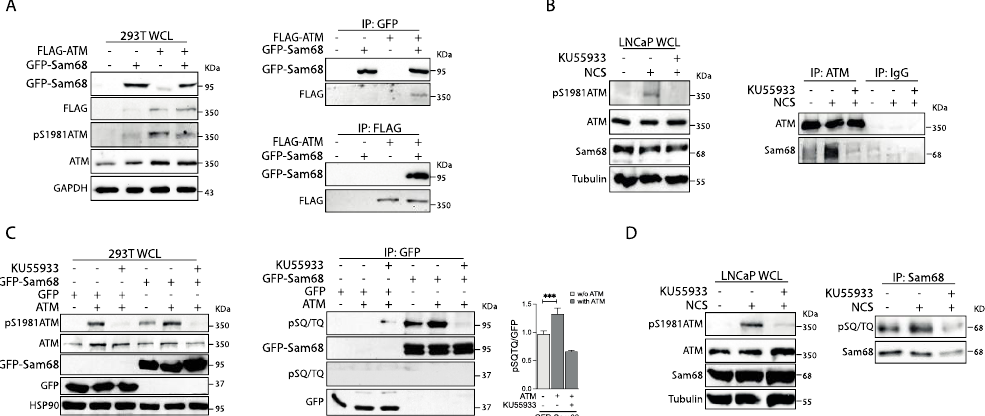
Figure 2. Sam68 interacts with ATM kinase, and it is phosphorylated on SQ/TQ motif upon DDR induction. ( A ) HEK293T cells were transiently transfected with a combination of different constructs that allow the overexpression of the fusion proteins GFP-Sam68 (pCDNA GFP-Sam68) and ATM-Flag (pCDNA FLAG-ATM) as indicated. Representative western blot of total protein extracts (whole-cell lysate, WCL) (293T WCL) and protein extracts subjected to co-immunoprecipitation assay. Co-immunoprecipitations were performed using anti-GFP (IP: GFP) or anti-FLAG (IP: FLAG) antibodies and immunoblotted with the indicated antibodies. ( B ) LNCaP cells were treated, or not, with KU55933 10 μM for 2 h and/or neocarzinostatin (NCS) 500 ng/mL for 1 h. Representative western blot of total protein extracts and protein extracts (LNCaP WCL) subjected to co-immunoprecipitation assay using anti-ATM (IP: ATM) antibody and IgG (IgG) as negative control. ( C ) HEK293T cells were transiently transfected as in ( A ) and treated, or not, KU55933 10 μM for 2 h. Representative western blot of WCL (293T WCL) and protein extracts subjected to immunoprecipitation assay using anti-GFP (IP: GFP) and immunoblotted with the indicated antibodies. Bar graph shows the densitometric analysis of pSQ/TQ signals with respect to GFP (western blot assays) in IP experiments (n = 3; mean ± s.d., *** p < 0.001, Student’s t test). ( D ) PC LNCaP cells were treated, or not, with KU55933 10 μM for 2 h and/or neocarzinostatin (NCS) 500 ng/mL for 1 h. Representative western blot of total protein extracts and proteins co-immunoprecipitated with anti-Sam68 antibody (IP: Sam68).